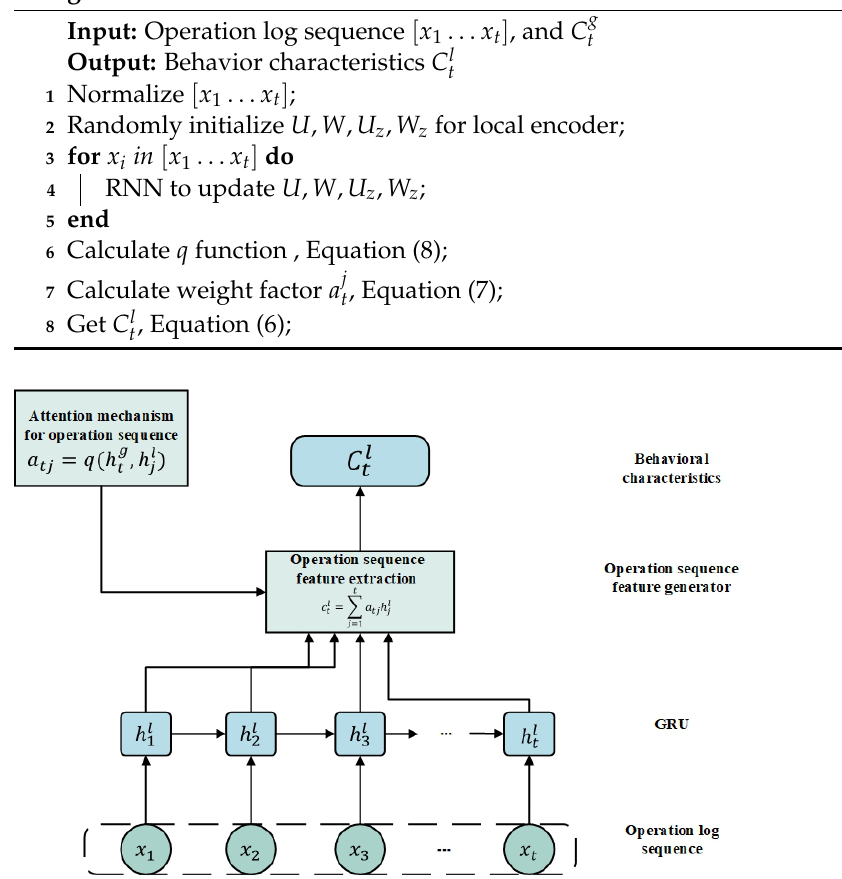
Figure 3. The local